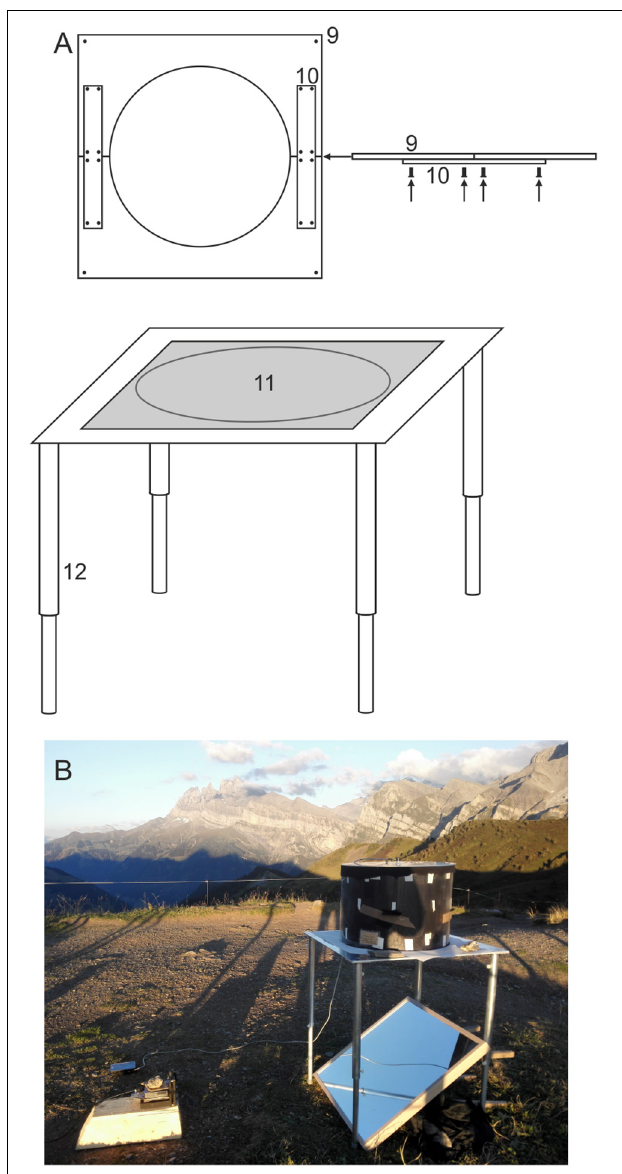
FIGURE 2 | The experimental table. (A) Schematic drawing of the experimental table showing the tabletop (9), the aluminum connectors (10), the circular opening (11), and the telescopic legs (12). (B) A photograph showing its deployment in the field at Col de Coux, Switzerland. For detailed explanation see